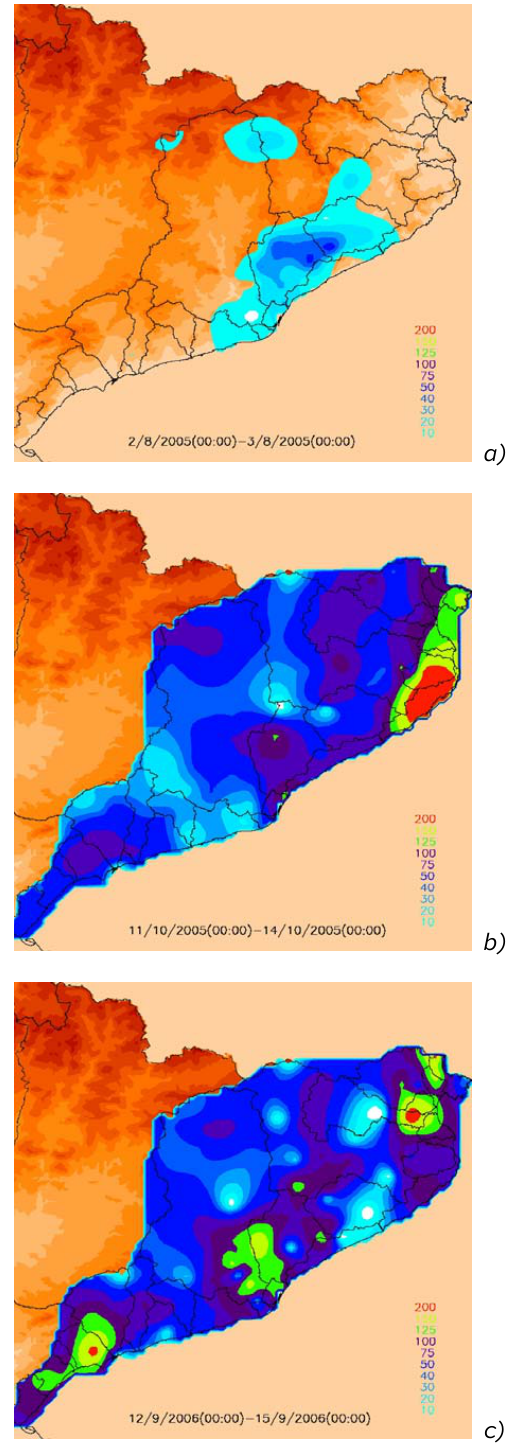
Fig. 5 : Total rainfall recorded in the Internal Basins of Catalonia, Spain, in the course of the events: a) 2 August 2005; b) 11-13 October 2005; c) 12-14 September 2006.